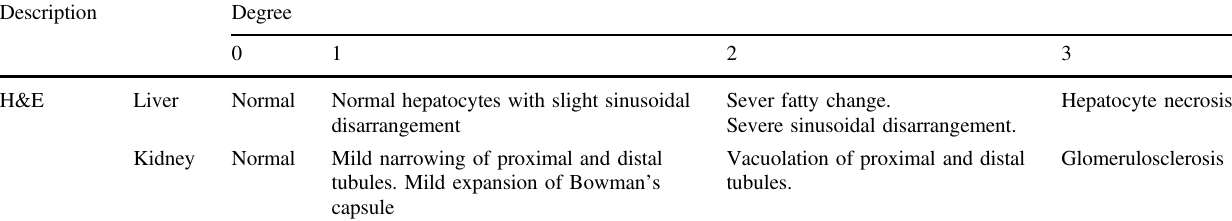
Fig. 1 Optical microscopic images of pH-responsive PTX/ niosome before niosome fi ltration at the magni fi cations of 40× and